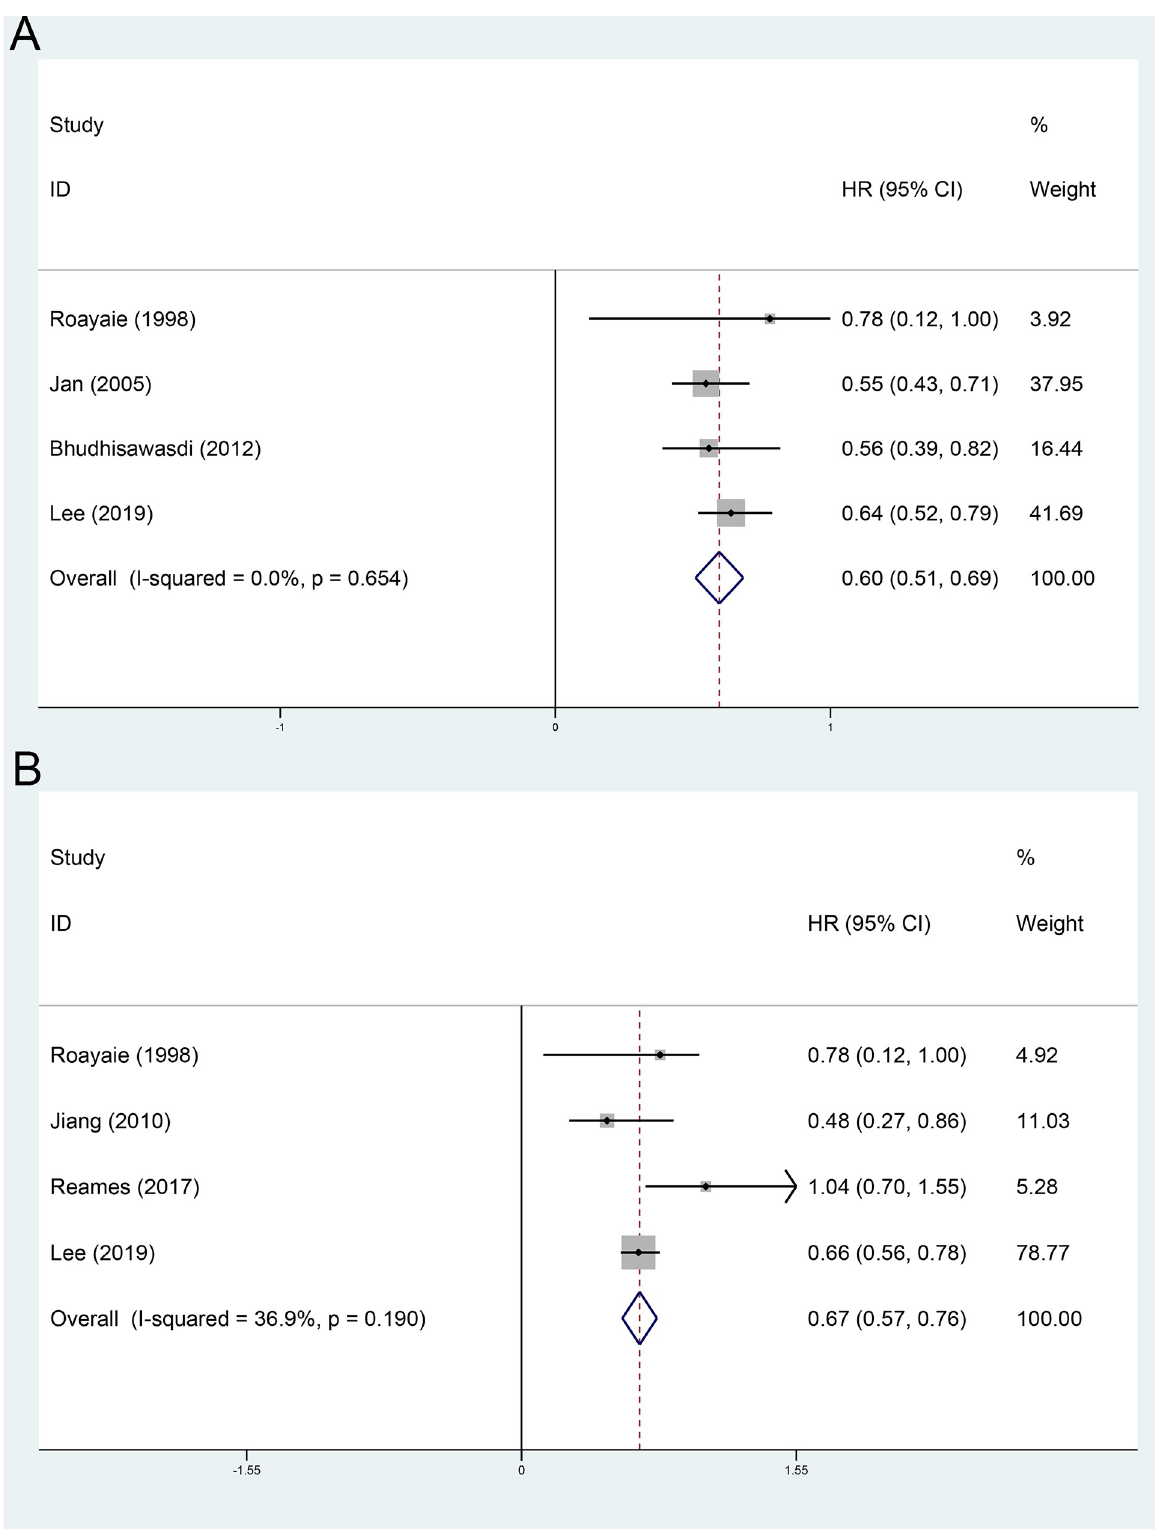
Fig 6. Subgroup analysis stratified by high risk factors. A, positive resection margin; B. lymph node metastasis.